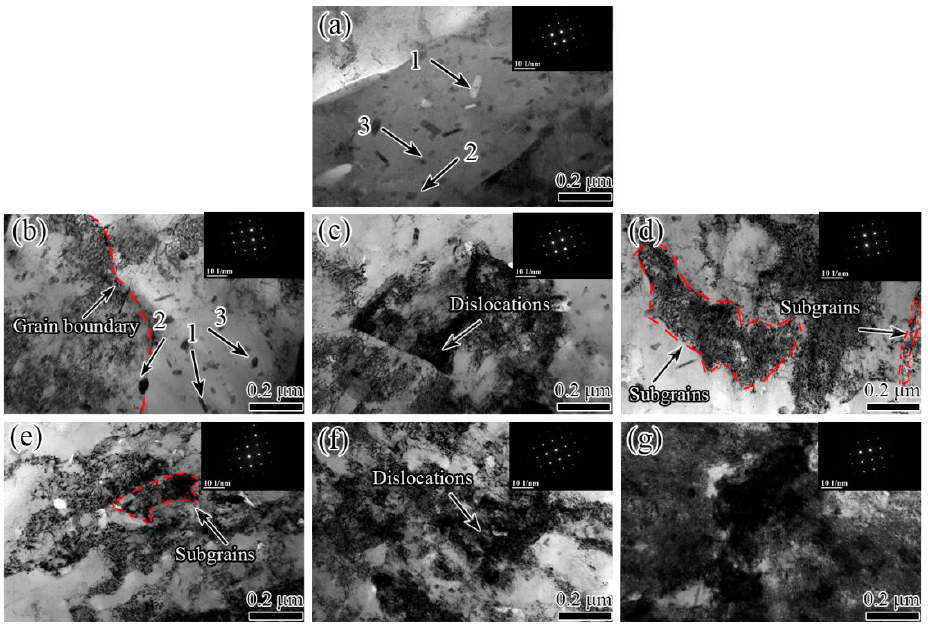
Figure 5. Bright-field transmission electron microscopy (BF-TEM) images of ( a ) undeformed and ( b – g ) pre-stretched annealed 7005 aluminum alloy plates (3%, 5%, 8%, 12%, 16%, and 20%, respectively).